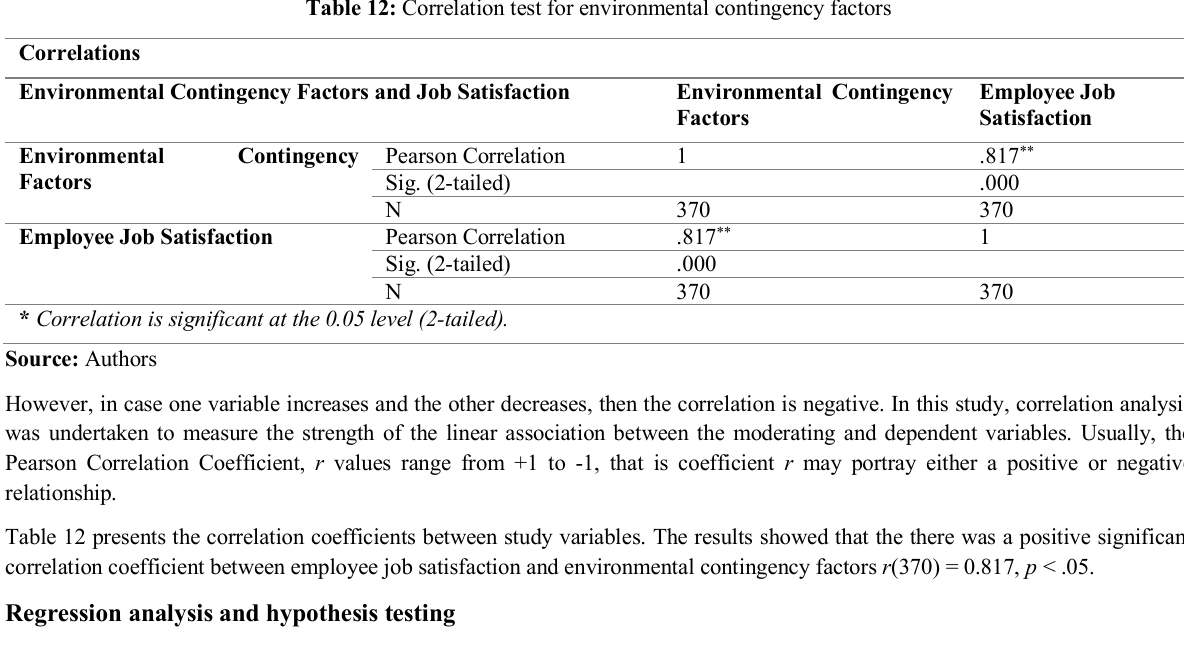
Table 12: Correlation test for environmental contingency